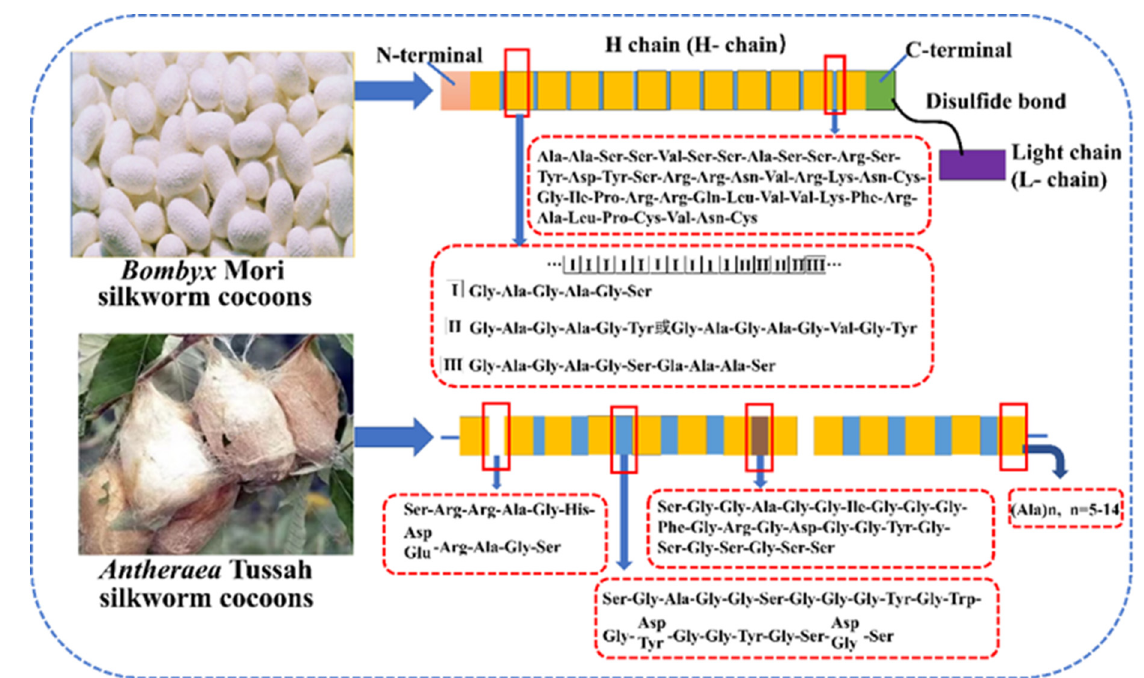
Figure 3. Representative amino acid sequences in SF (H chain) of Bombyx mori silkworm and Antheraea tussah silkworm (reproduced with permission from [49], Copyright (2016) American Chemical Society and reproduced with permission from [54], Copyright (2022) Elsevier).